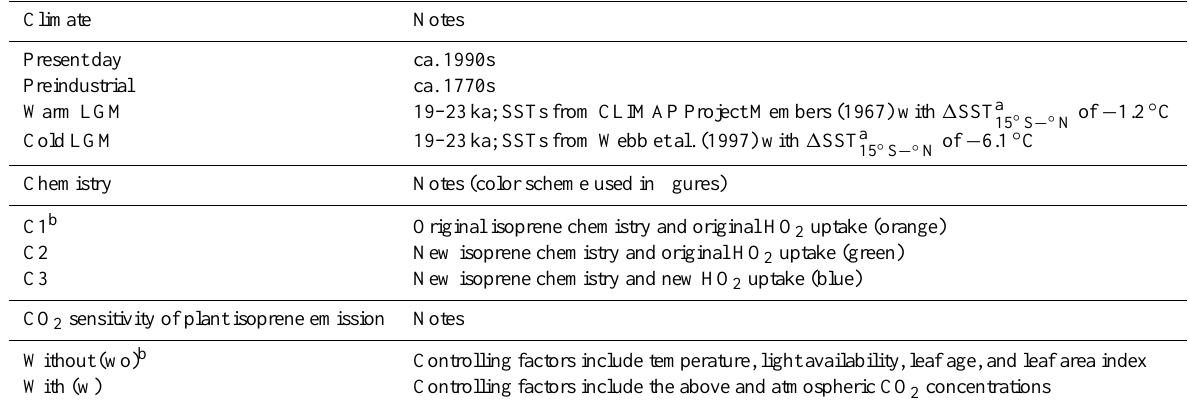
Table 2. Summary of the different climate, chemistry, and plant isoprene emission scenarios tested in this model study. For each climate scenario except for the present day, all possible combinations of chemistry and emission schemes are tested (for the present day, only the “with” CO 2 sensitivity scheme is used). We perform 21 simulations in total.